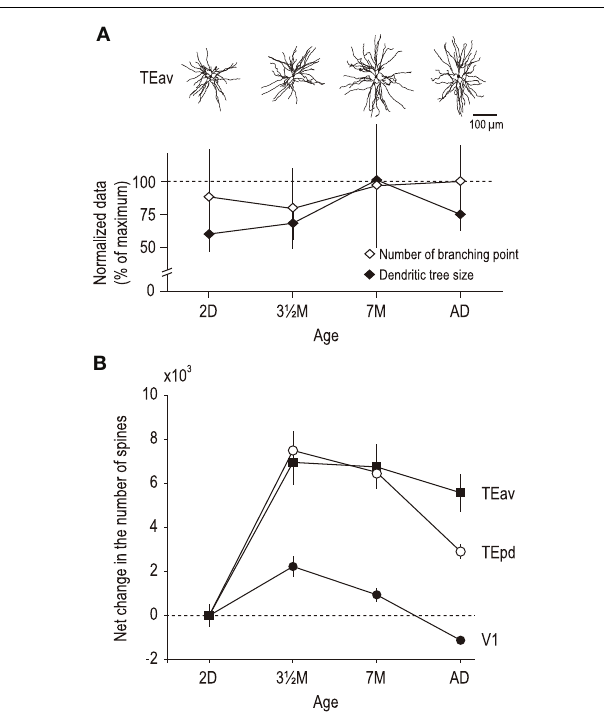
FIGURE 4 | (A) Plot illustrating how different aspects of basal dendritic tree structure, such as the size and branching structure, of layer III pyramidal neurons inTEav may vary independently with aging. For example, from 2days of age (2D) to three and a half months of age (3.5month) there is a decrease in branching complexity coupled with an increase in the size of the dendritic trees. From 7months of age (7month) to four and a half years of age (AD) there is an increase in branching complexity coupled with a decrease in the size of the dendritic trees. (B) Plots of net change in number of spines in the basal dendritic trees of pyramidal cells inTEav, TEpd, andV1 from 2days of age into adulthood. Note there is a net gain in the number of spines in the basal dendritic trees of cells in high level association areasTEav andTEpd, but a net loss of spines in areaV1. A net loss in the total number of spines in the basal dendritic trees of layer III pyramidal cells has also been reported in the primary auditory area over the same period (Elston et al., 2010b). Error bars =